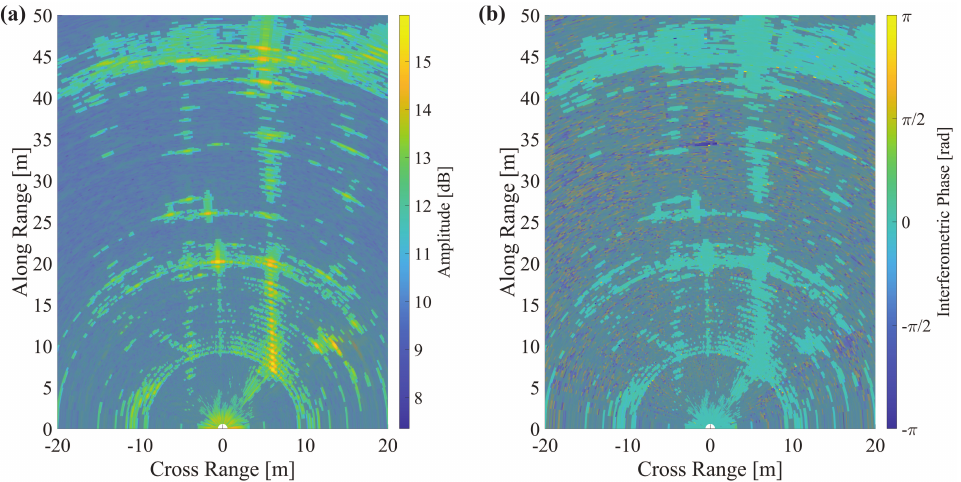
Figure 9. ( a ) Amplitudes and ( b ) phase differences between two subsequent acquisitions associated with the dynamic outdoor experiment. The images are overlaid with a partially transparent mask for better